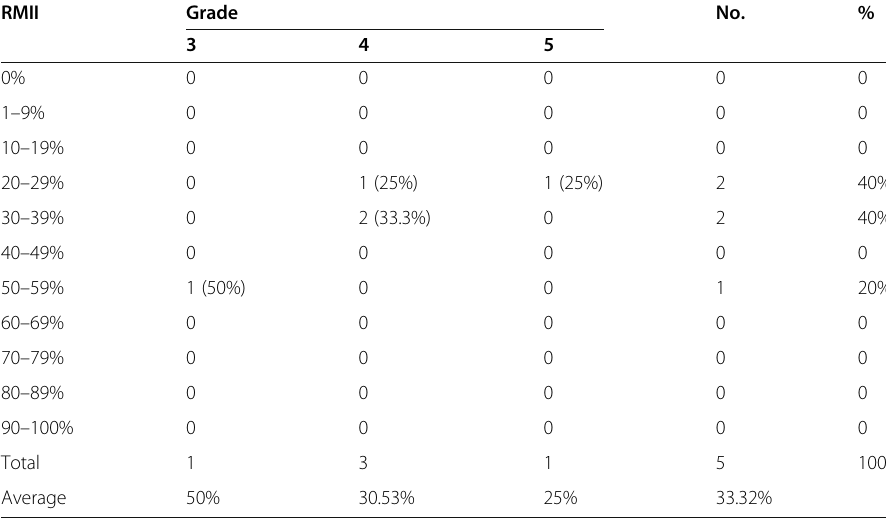
Table 6 Status of RM implementation: company level